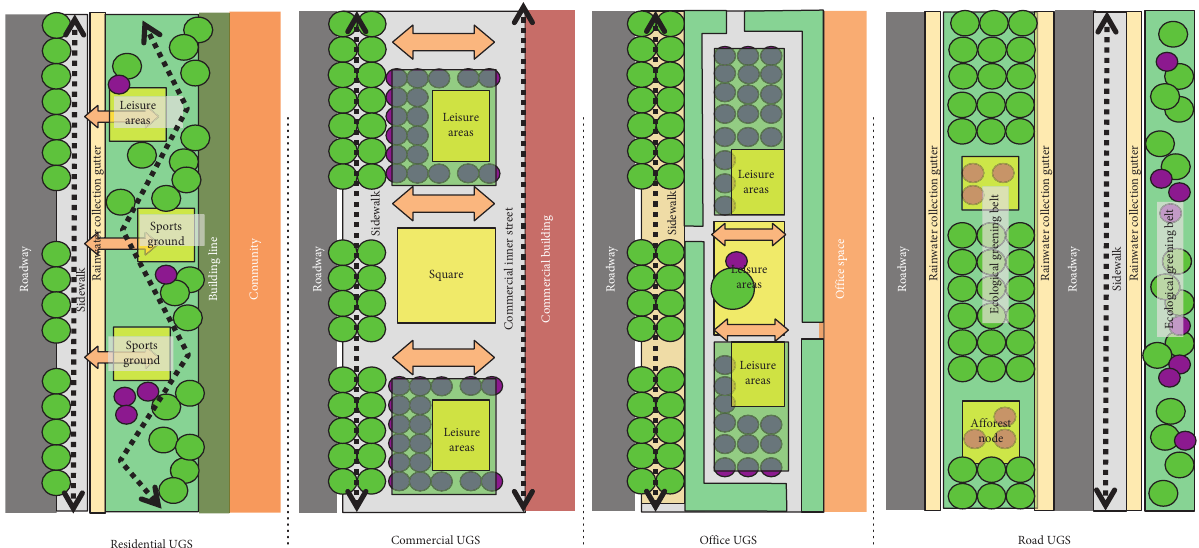
Figure 7: Typical UGSs plan that meets the needs of the